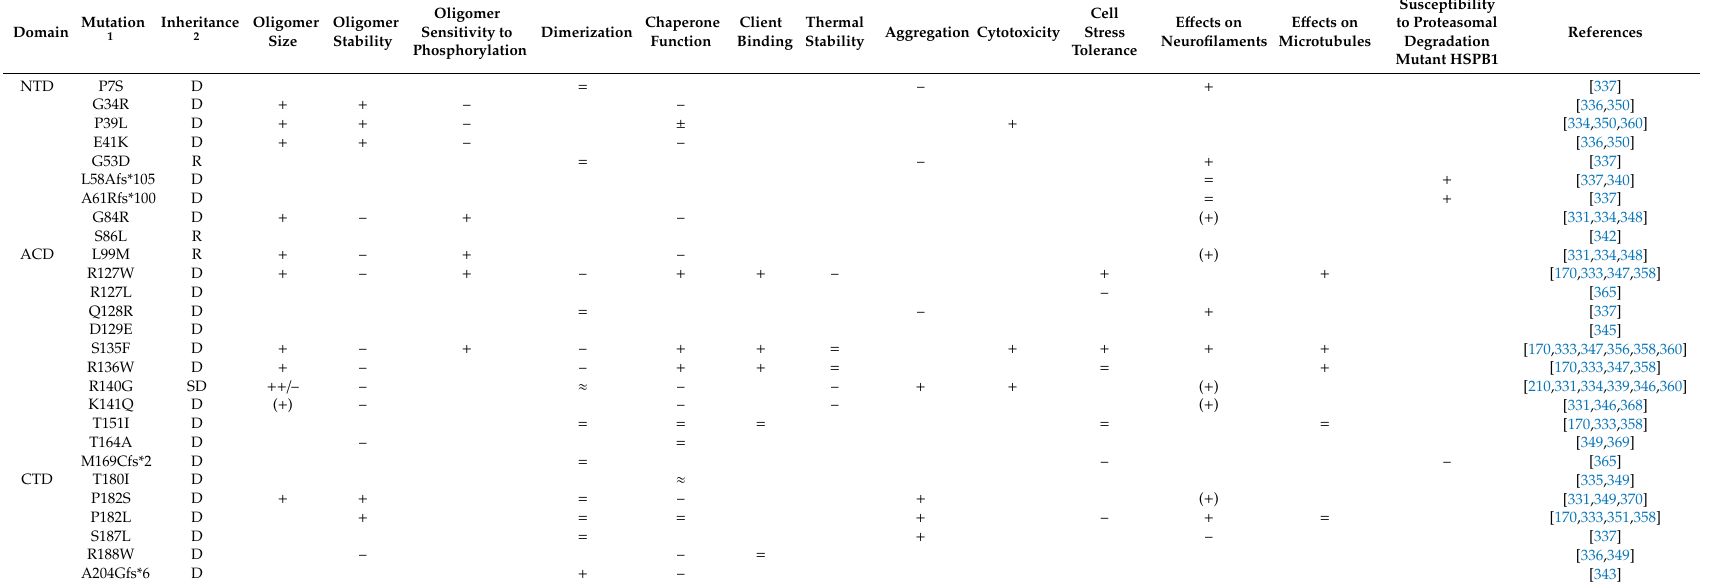
Table 6. Functional consequences of HSPB1 mutations. NTD: N-terminal domains, CTD: C-terminal